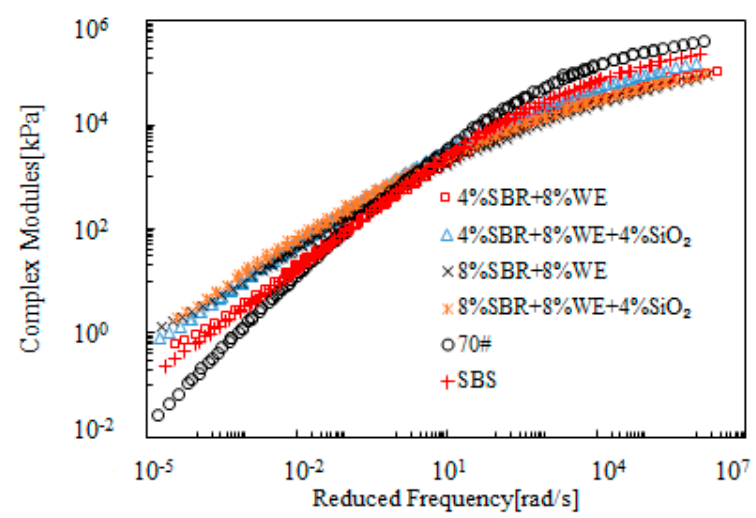
Materials 2019 , 12 , x FOR PEER REVIEW Figure 17. Master curves of complex modulus of SBR + WE + SiO 2 -modified bitumen emulsion.